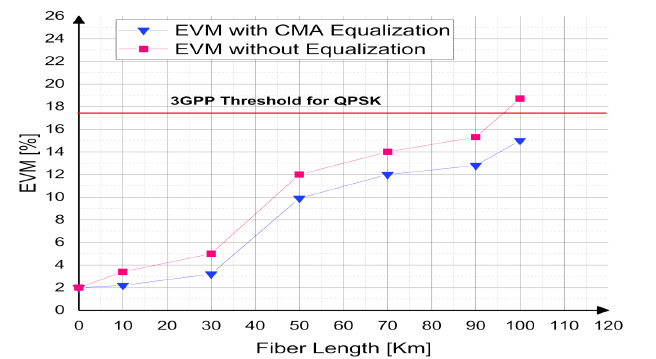
Figure 14. EVM results obtained before and after Constant Modulus Algorithm (CMA) equalization vs the fiber lengths for the QPSK